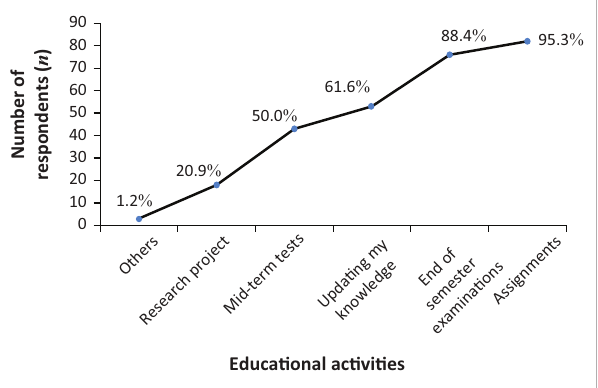
FIGURE 2: Kinds of educational activities ( n =